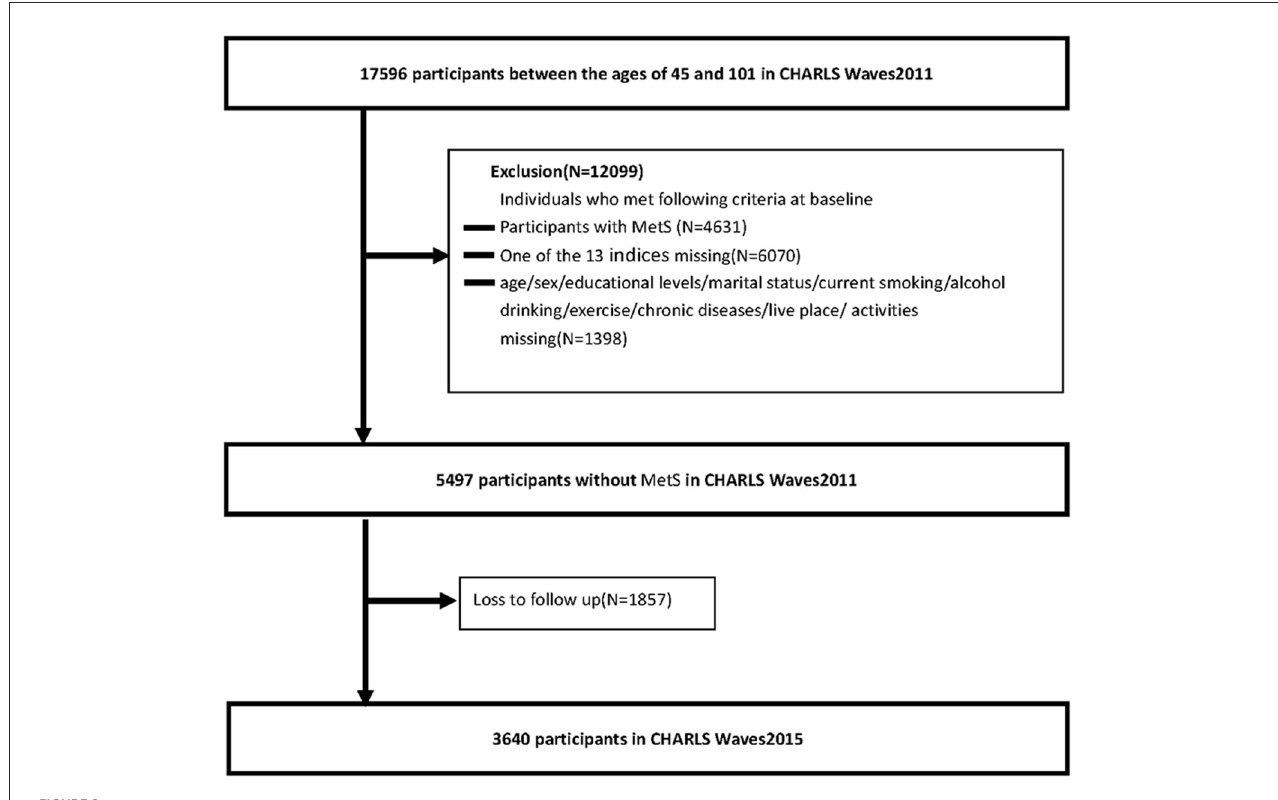
FIGURE2 Flowchart of the study